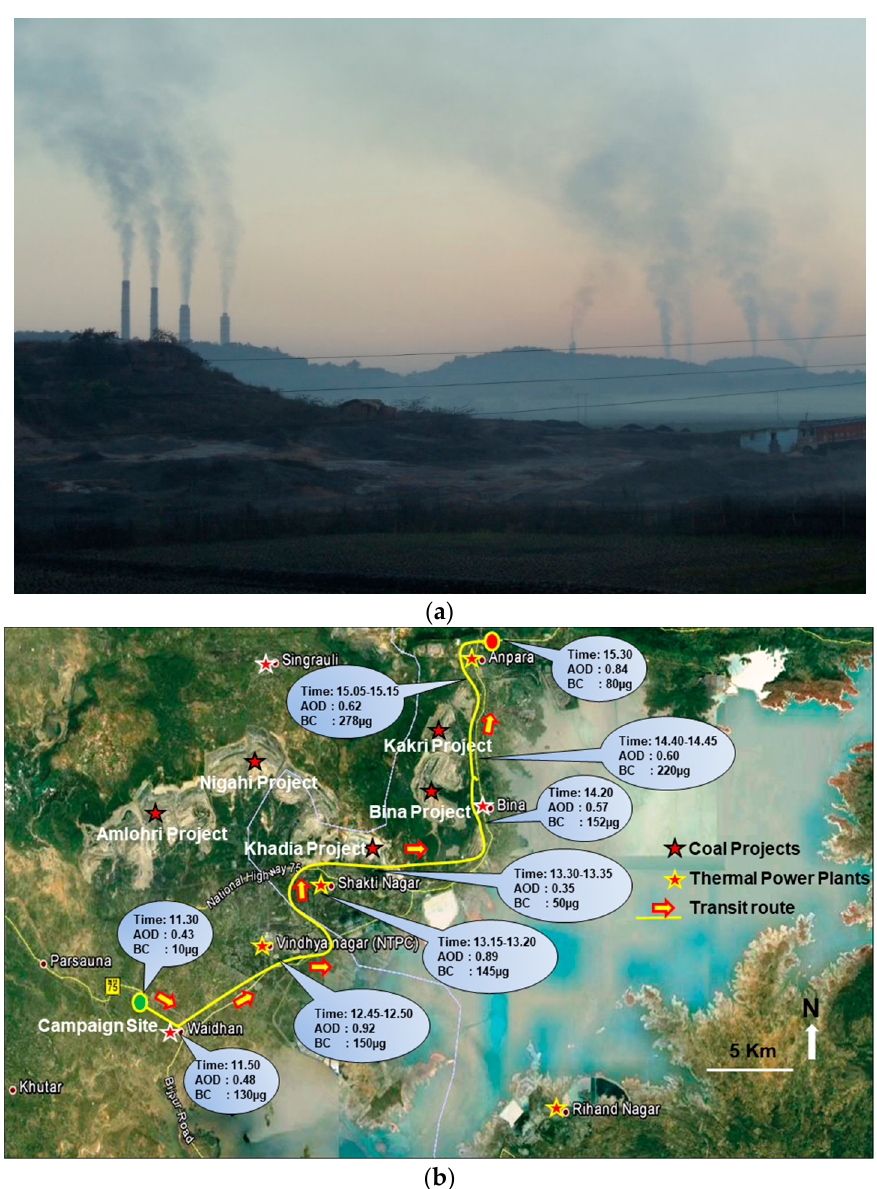
Figure 2. ( a ) The clear view of coal-fired power plants located in the Singrauli area (photo is taken by the main author—RPS); ( b ) The satellite picture showing the Singrauli region (black rectangle area in Figure 1), the fixed campaign site (Green filled spot), transit measurement route (Yellow line), power plants, coal mining areas, and GB Pant water reserve with corresponding time (h), AOD and BC values ( µ gm − 3 ). (Picture Source: Google map).